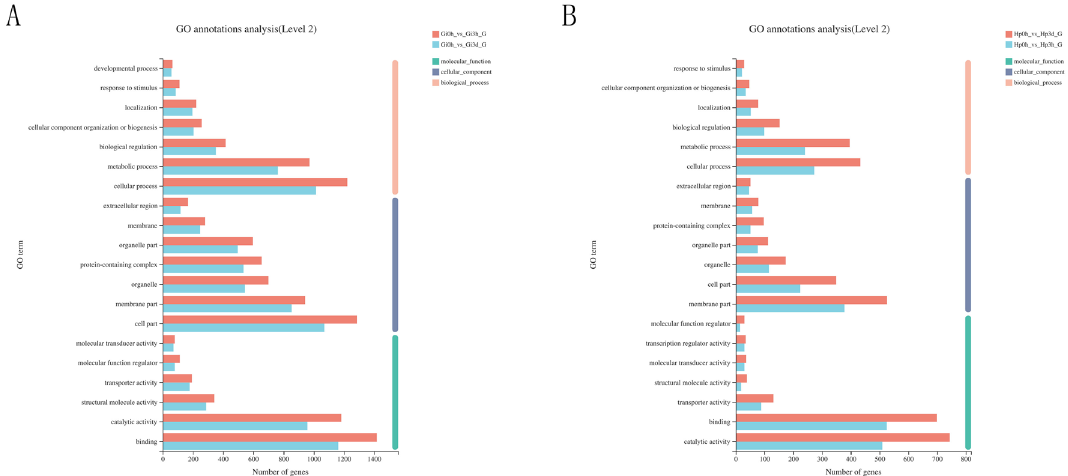
Figure 5. Gene ontology functional analyses of differentially expressed genes. ( a ) Gi 0 h vs Gi 3 h and Gi 0 h vs Gi 3 d. ( b ) Hp 0 h vs Hp 3 h and Hp 0 h vs Hp 3 d. Each annotated sequence is assigned at least one GO term from biological process, cellular component or molecular function. The abscissa represents the GO terms and the ordinate represents the number of genes. Gi, gill; HP, hepatopancreas; 0 h, control; 3 h, Cd 2+ treated 3 h; 3d, Cd 2+ treated 3